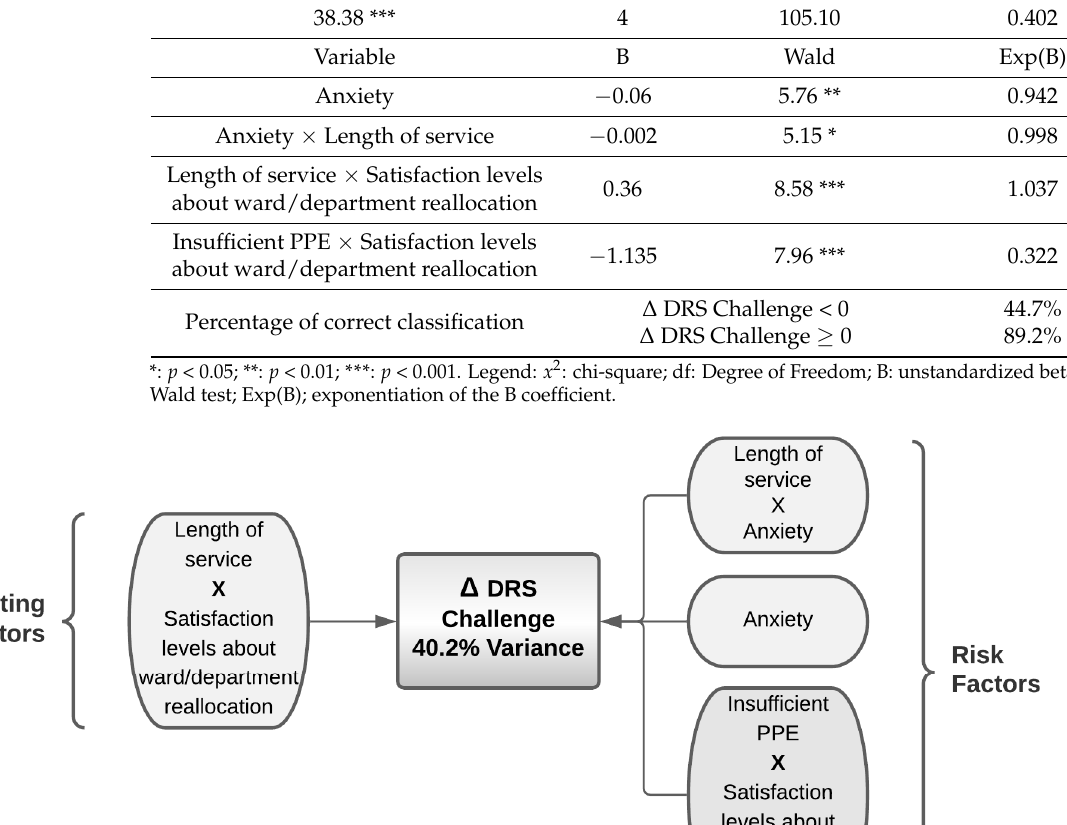
Table 22. Challenge predictors according to multivariate analysis (anxiety, anxiety × seniority of service, anxiety × transfer evaluation, PPE (no) × transfer evaluation) and correct/incorrect classification of the model.